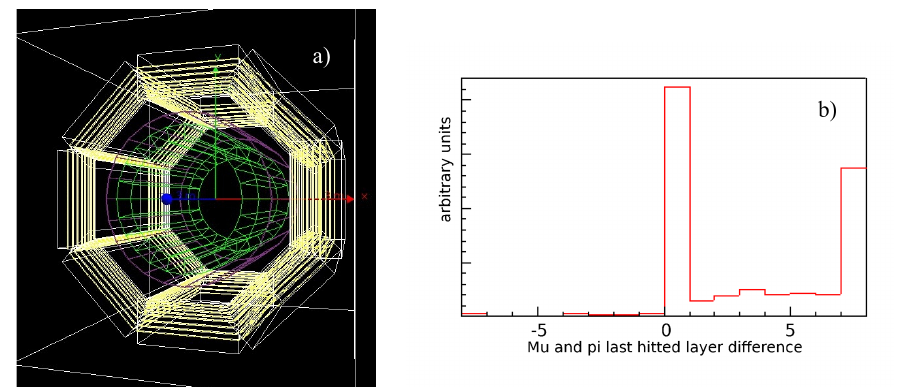
Figure 1. a) Simplified detector design used for simulation. CsI calorimeter is drawn with the green lines, while superconducting magnet with magenta lines. White and yellow lines designate absorber and detector layers of the multilayer muon system, respectively. b) Di ff erence in the number of the last layers, reached by pions and muons of the same momenta. Positive values correspond to the e ff ective π/µ identification, negative to fakes. Zero values are